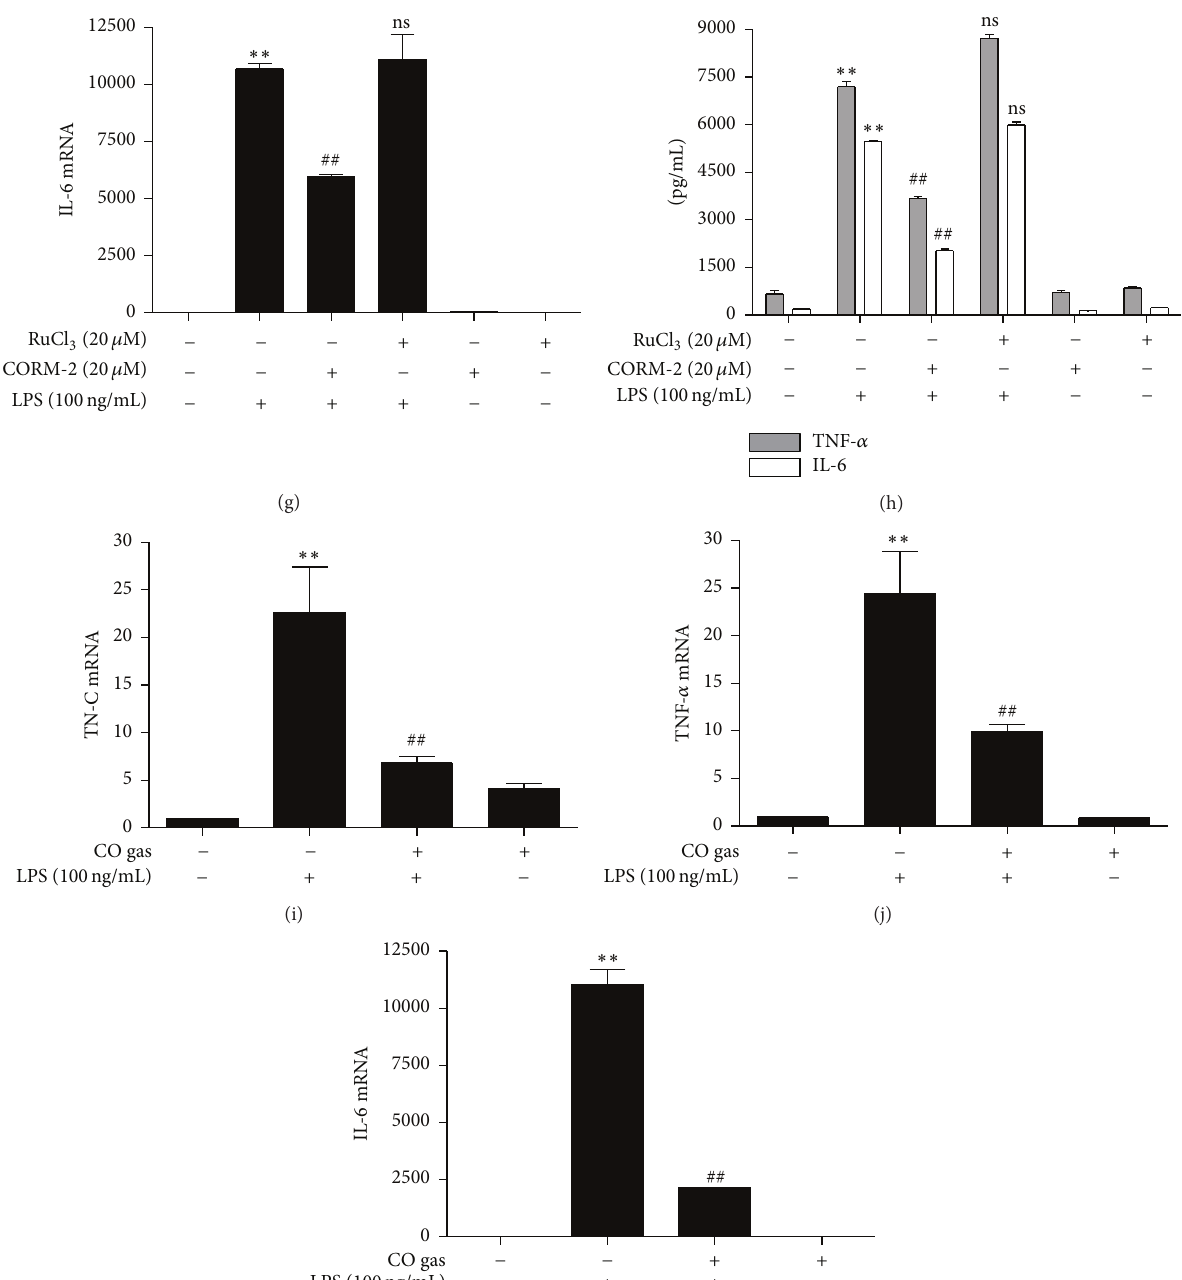
Figure 2: CO inhibits LPS-induced TN-C expression and proinflammatory cytokines in RAW 264.7 macrophages. (a–d) To detect the TN-C expression and proinflammatory cytokine production, macrophages were pretreated with CORM-2 (0, 10, 20, and 40 𝜇 M) for 1 h and then stimulated with LPS (100ng/mL) for 8 h. The protein levels (upper) and mRNA levels (lower) of TN-C were measured by Western blotting and Real Time RT-PCR. The mRNA levels (b, c) and protein levels (d) of TNF- 𝛼 and IL-6 were reduced by CORM-2. The amount of mRNA with Real Time RT-PCR was detected and protein expression was measured with ELISA after 24 h of LPS treatment. (e–h) Cells were pretreated with CORM-2 (20 𝜇 M) or RuCl 3 (20 𝜇 M) for 1h followed by stimulation in the presence or absence of LPS (100 ng/mL) for 8 h. RuCl 3 was used as a negative control for CORM-2. The levels of mRNA in TN-C (e), TNF- 𝛼 (f), and IL-6 (g) after treatment of CORM-2 were measured by Real Time RT-PCR and the protein levels of TNF- 𝛼 and IL-6 were detected by ELISA after 24 h of LPS treatment (h). (i–k) Cells were pretreated with CO gas (250 ppm) for 2 h and incubated with LPS (100ng/mL) stimulated for 8h. TN-C (i), TNF- 𝛼 (j), and IL-6 (k) mRNA levels were detected by Real Time RT-PCR. Data represents mean ± SEM, ∗∗ 𝑃 < 0.001 as compared with control; ## 𝑃 < 0.001 and ns, nonsignificant, as compared with the cells exposed to LPS